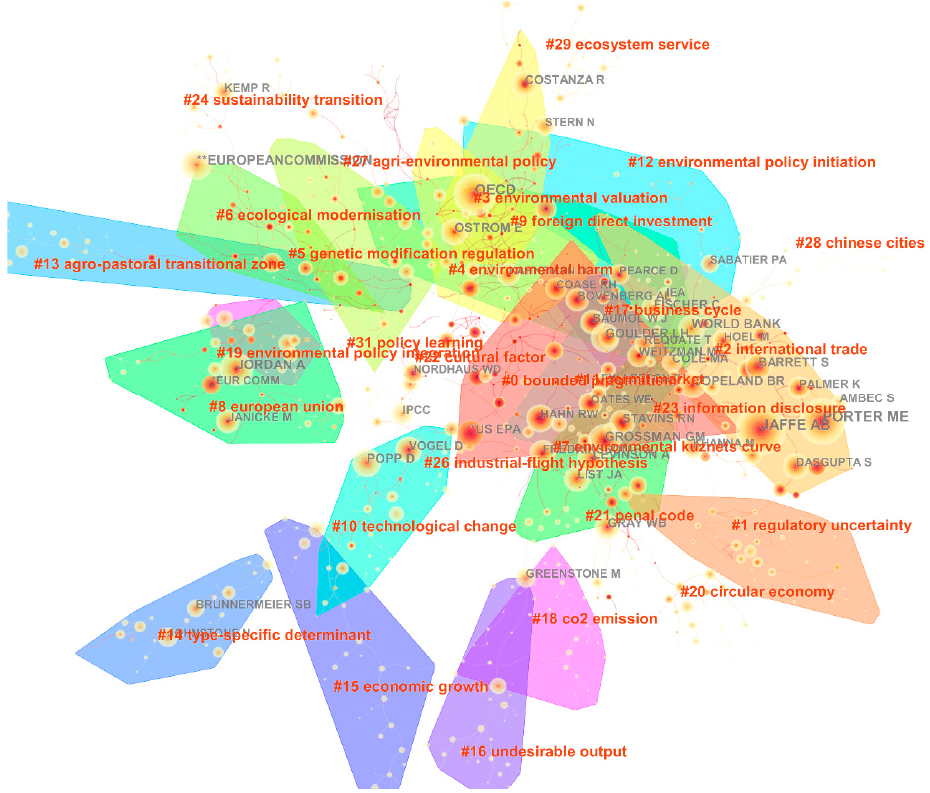
Figure 7. Co-citation network of authors in research on environmental regulation from 2000 to 2019.